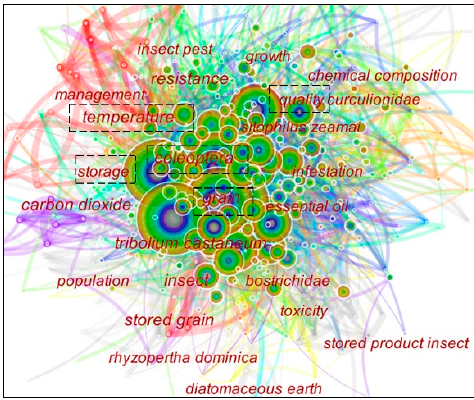
Figure 6. Keyword cooperation network map. Table 5. Information table of the top 20 keywords. Ranker Count